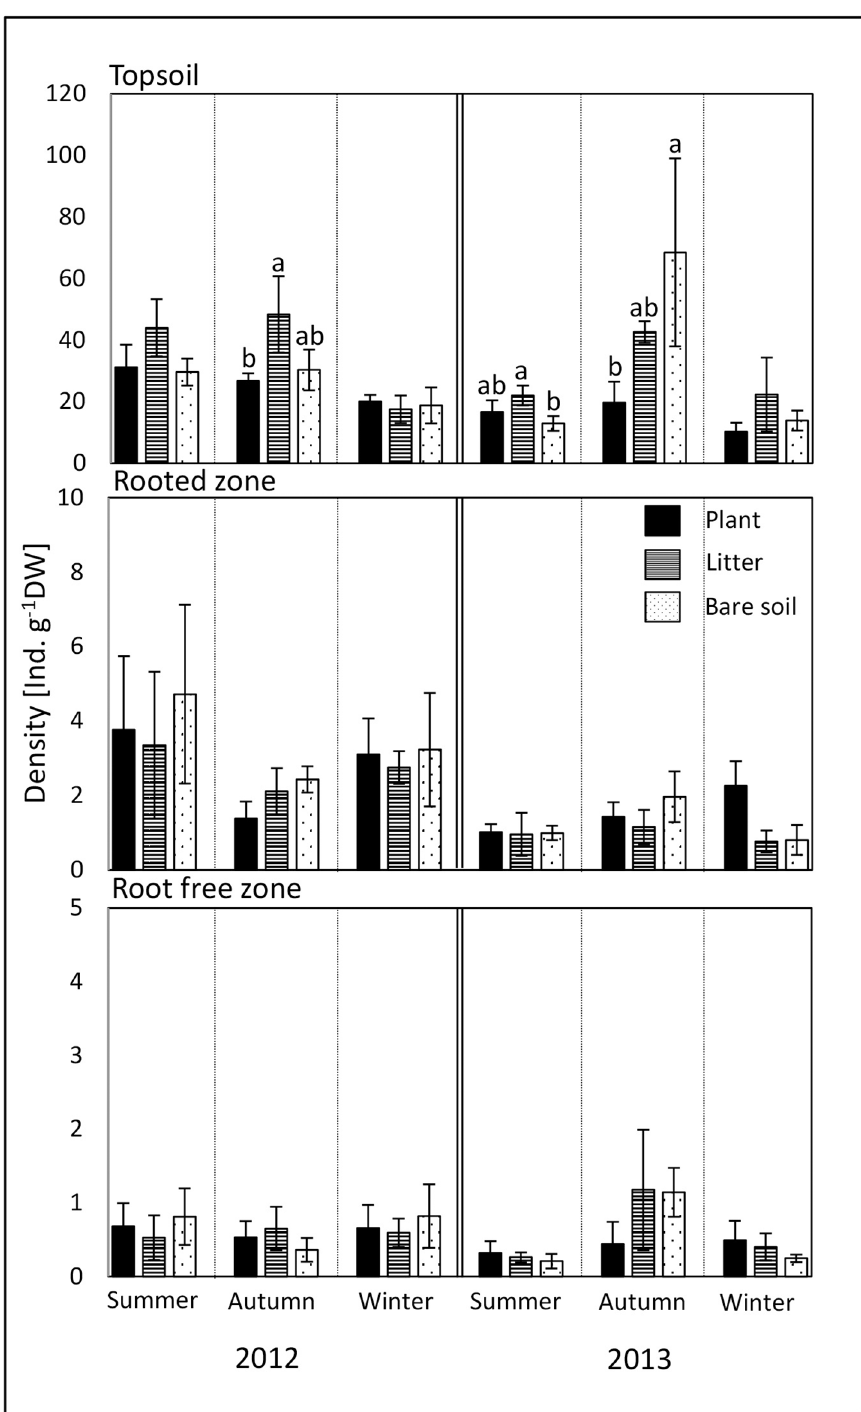
Fig 2. Density (individuals g -1 dry weight soil ± SD) of nematodes in soil cropped with maize (plant), amended with maize shoot litter (litter) or bare soil, in topsoil (0–10 cm), rooted zone (40–50cm), and root free zone (60–70cm) in the years 2012 and 2013. Valueswithin a samplingdate with the same or no letters are not significantly different accordingto Tukey´s HSD test at P < 0.05.